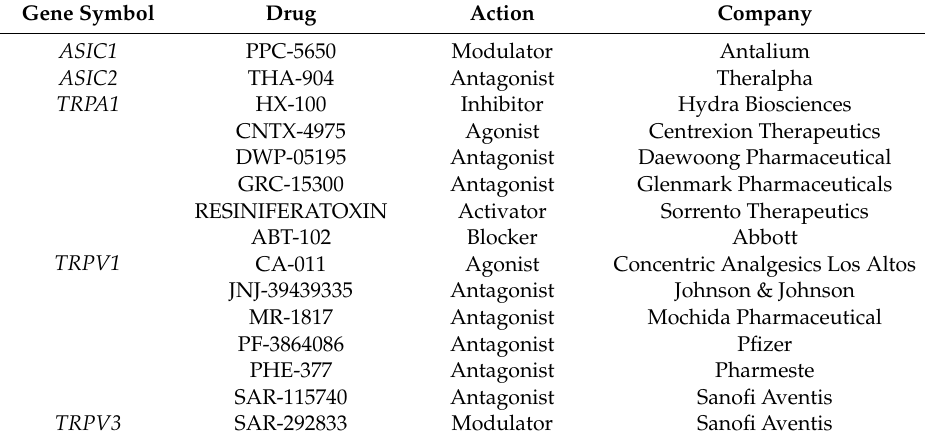
Table 1. Novel analgesic drugs developed with the purpose of targeting proteins / genes associated with human hereditary insensitivity to pain—i.e., to mimic the pain insensitivity phenotype observed in carriers of loss of function mutations in these genes—that are currently in a clinical phase of development. The information was queried on January 2020 from the Therapeutic Target Database at http: // db.idrblab.net